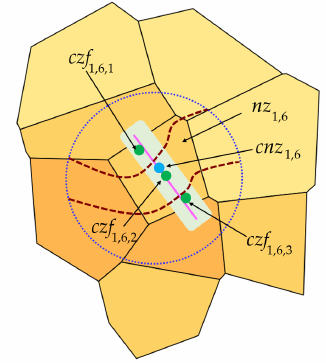
Figure 5. Display of the output of the operation of line buffering of lr i , j . cnz 1,6 (the blue dot) is the centroid of the nearest zone ( nz 1,6 ) where the line runs